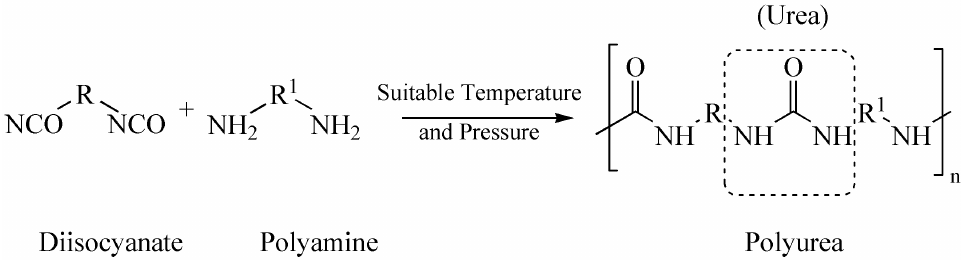
Figure 1. Polyurea formation chemical reaction. R and R1 denote alkyl groups.